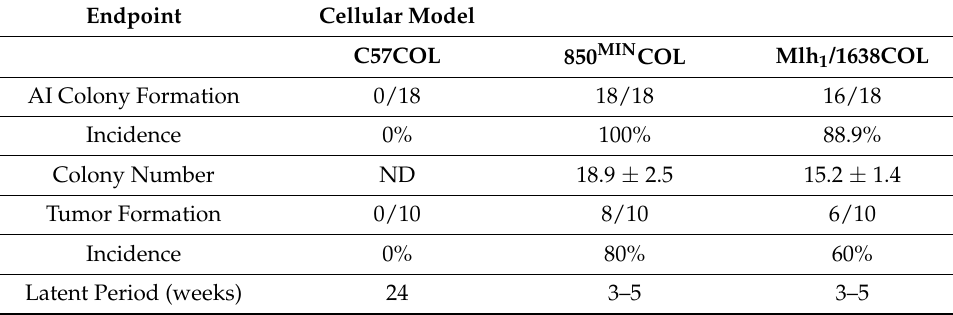
Table 3. Growth characteristics of cellular models for colon